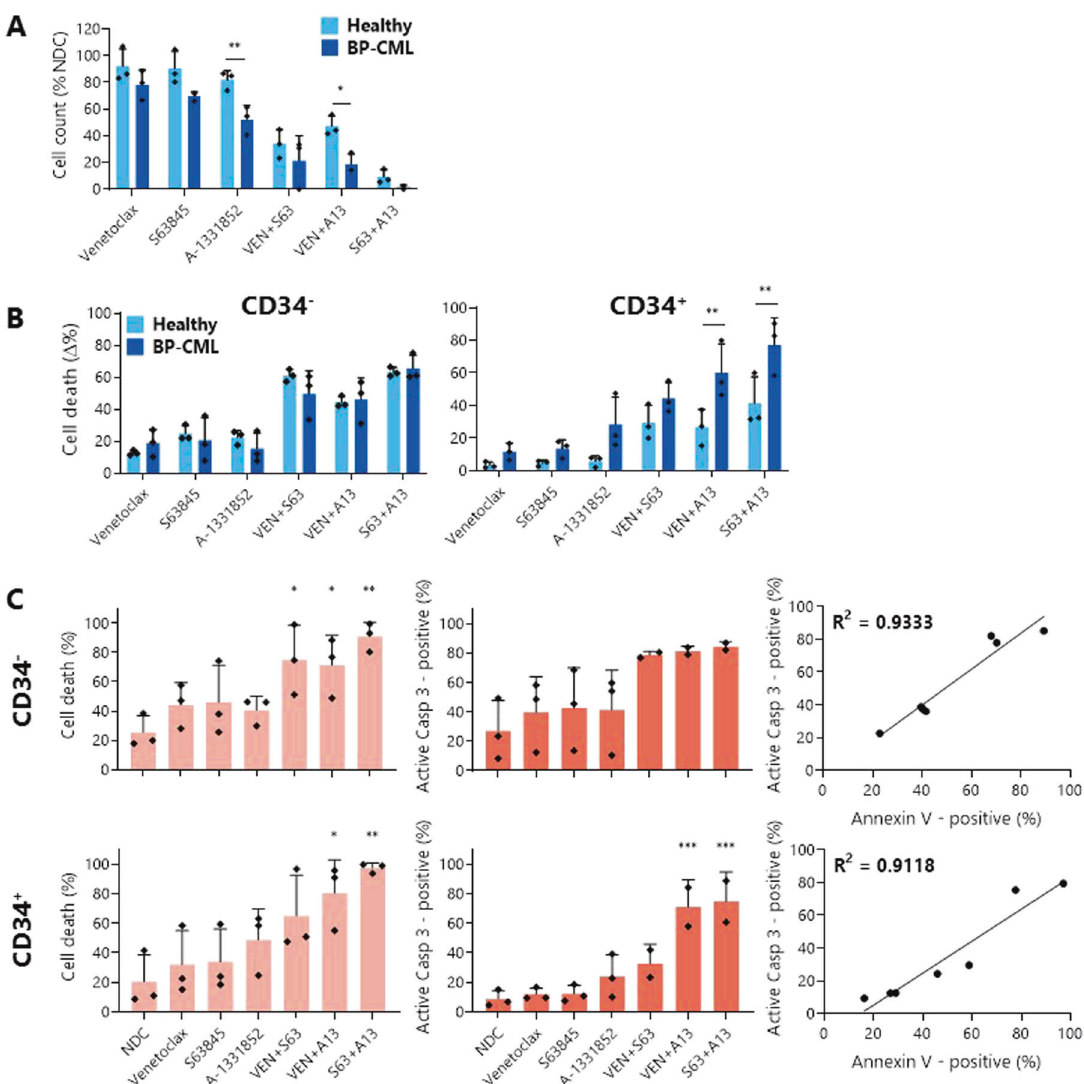
Fig. 4 Combining BH3 mimetics in BP-CML patient samples induces a greater degree of apoptosis than single treatments. The effect of 1 µM indicated BH3 mimetic after 72 h treatment in three healthy donor control and three myeloid BP-CML patient samples on viable cell counts ( A ) and Annexin V/DAPI staining ( B ) was measured and analyzed by two-way ANOVA. Signi fi cant differences can be seen in Supplementary Tables 6 and 7. Staining with anti-CD34 allowed discrimination between cell death in CD34 − and CD34 + cells. Apoptosis was con fi rmed by staining for Annexin V/DAPI (light orange) and active caspase-3 (dark orange) in CD34 − and CD34 + myeloid BP-CML cells after 72 h treatment with 1 µM BH3 mimetics and correlation between both was determined, N = 3 ( C analyzed by one-way ANOVA). * p ≤ 0.05, ** p ≤ 0.01, *** p ≤ 0.001. Data are represented as mean ±